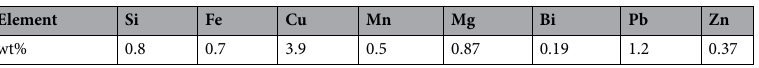
Table 2. Chemical composition of Al alloy